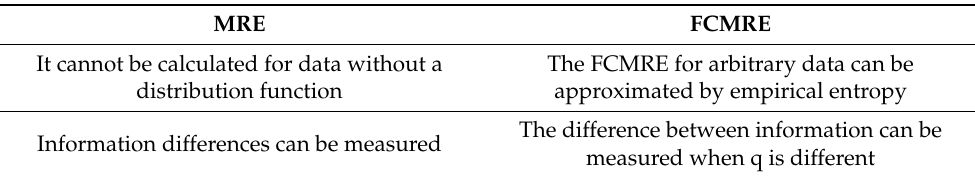
Table 2. Advantages of FCMRE compared with MRE.